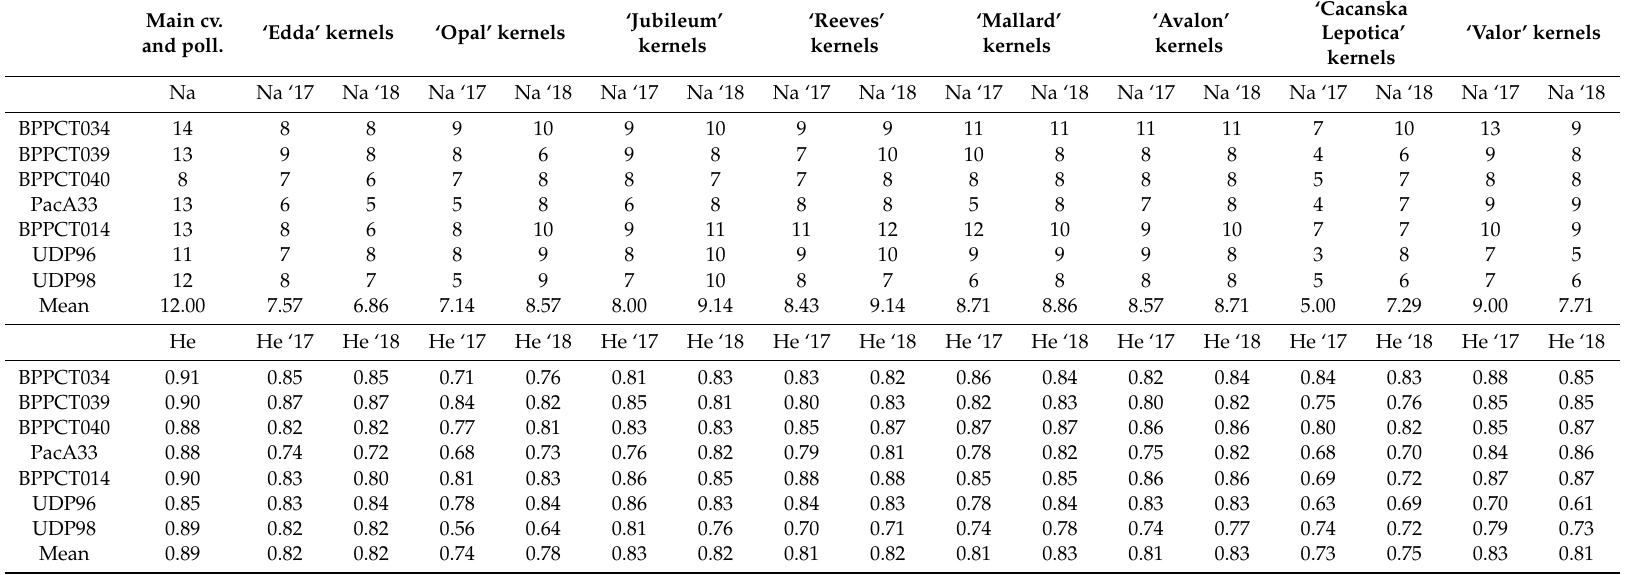
Table 3. Number of alleles per locus (Na) and gene diversity (He) [34] for the main and pollinizer cultivars (‘Herman’, ‘Edda’, ‘Mallard’, ‘Victoria’, ‘Opal’, ‘Avalon’, ‘Valor’, ‘Cacanska Lepotica’, ‘Jubileum’, ‘Excalibur’, and ‘Reeves’), as well for, collected ‘Edda’, ‘Opal’, ‘Jubileum’, ‘Reeves’, ‘Mallard’, ‘Avalon’, ‘Cacanska Lepotica’, and ‘Valor’ embryos, in 2017 and 2018, based on seven SSR (simple sequence repeat) loci. Main cv. and